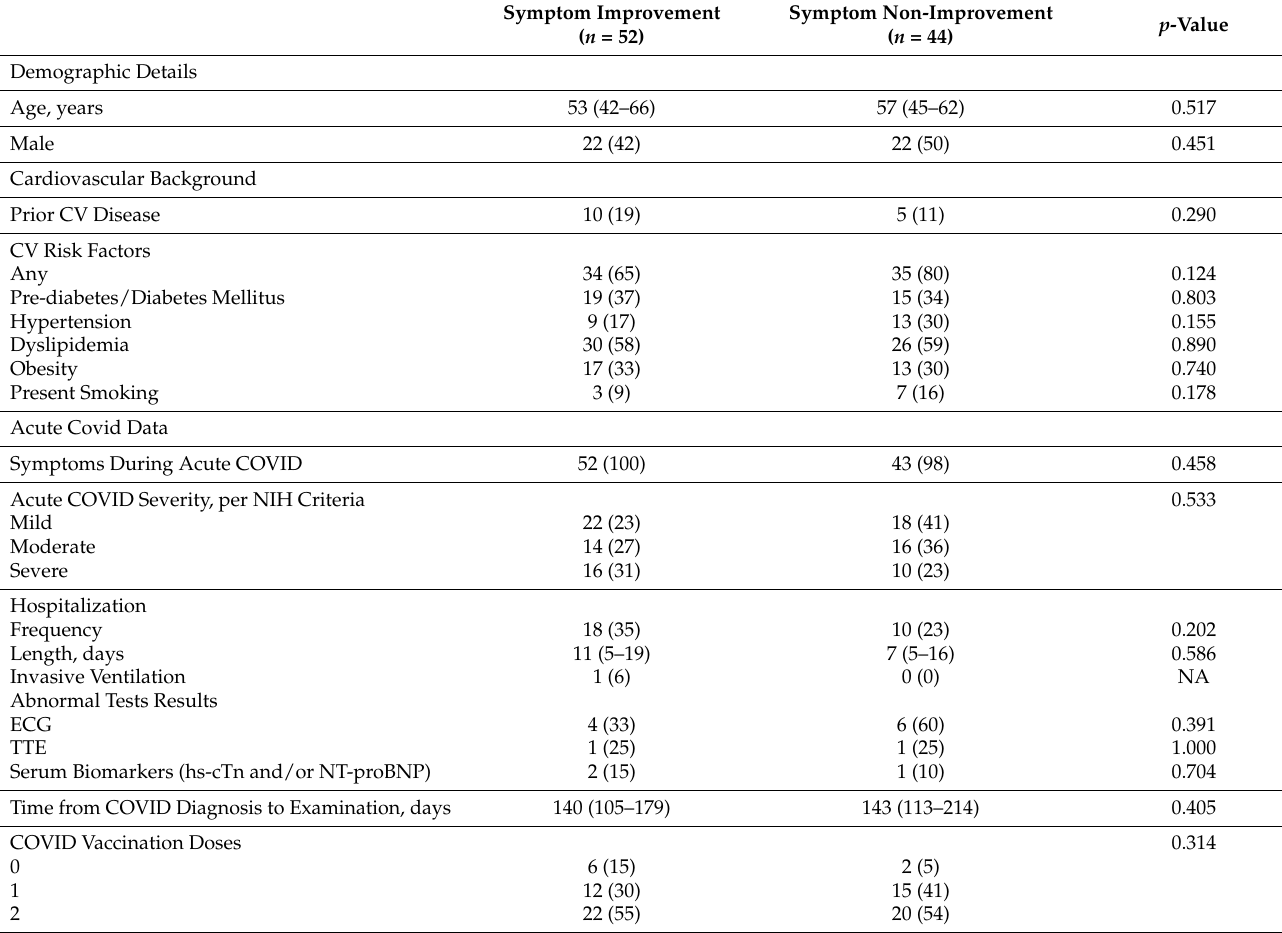
Table 7. Baseline patient characteristics according to symptomatic course.